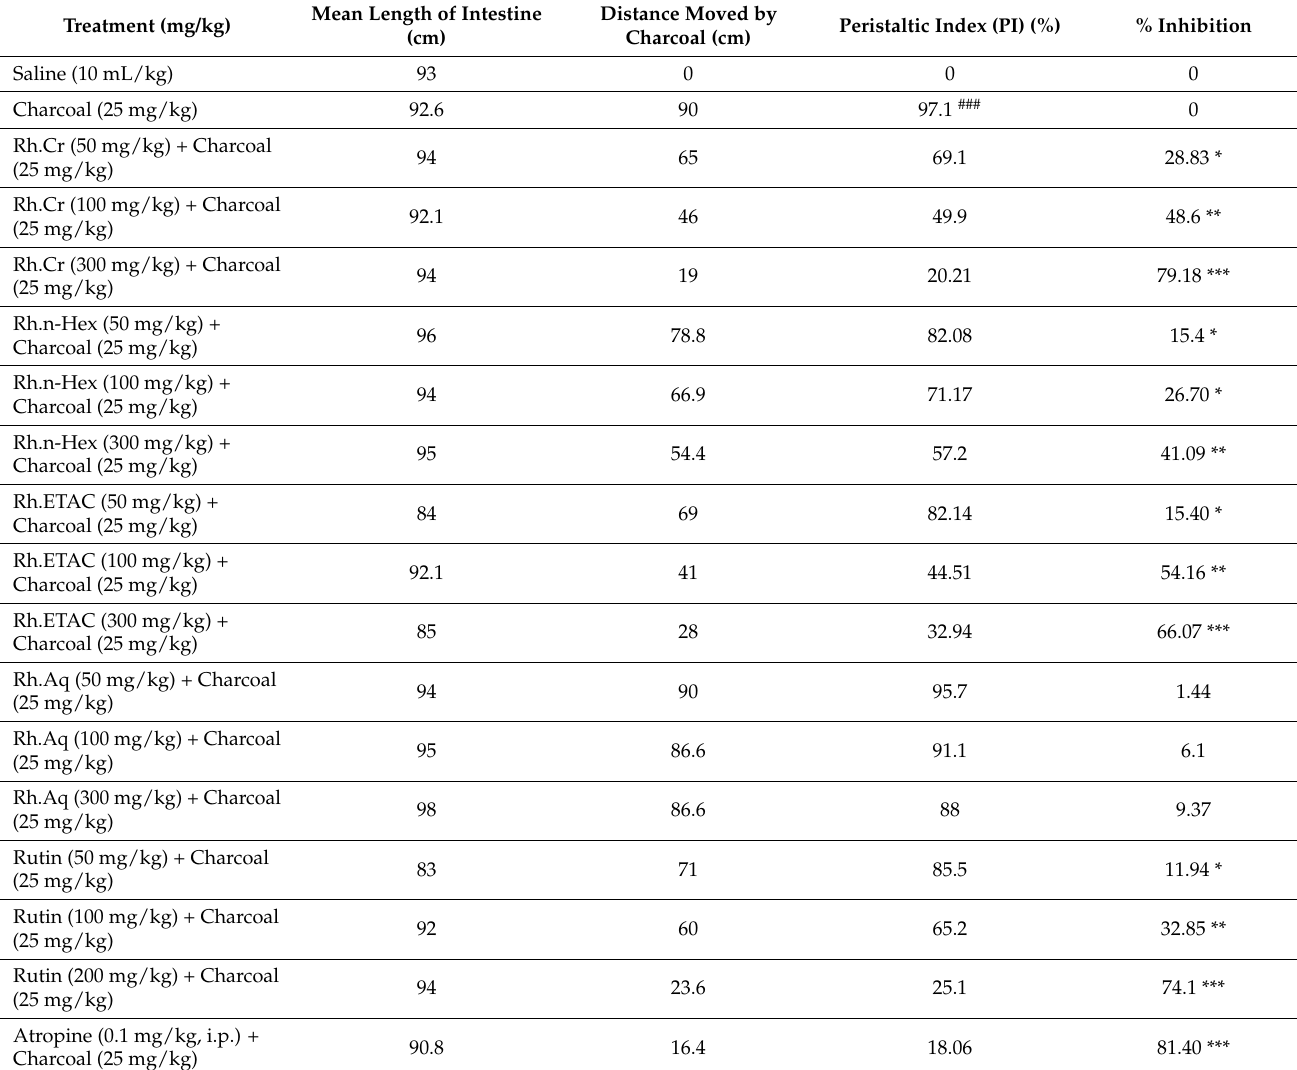
Table 5. Effect on Rumex hastatus crude extract (Rh.Cr) and fractions: n-hexane (Rh.n-Hex),